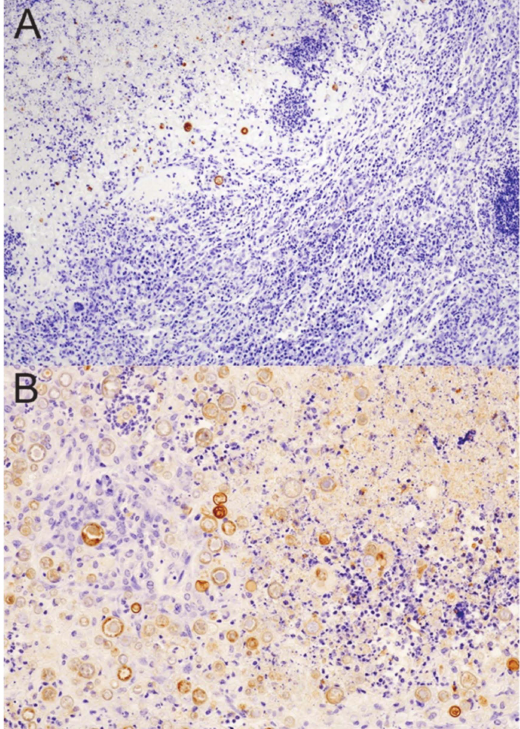
Figure 6. Coccidioides -specific stain of spherules prior to and after DXM immunosuppression. ( A ) There are few spherules (brown stain) confined to the necrotic core of a controlled granuloma in an untreated mouse. ( B ) Sheets of spherules are found throughout the disorganized pyogranulomatous lesion (former granuloma) in a mouse treated for 20 days with DXM. Note that many of the spherules in this image are only minimally stained. (Stain: polyclonal goat anti-PRA Ab with a hematoxylin counterstain; magnification ( A )— × 100; ( B )— ×